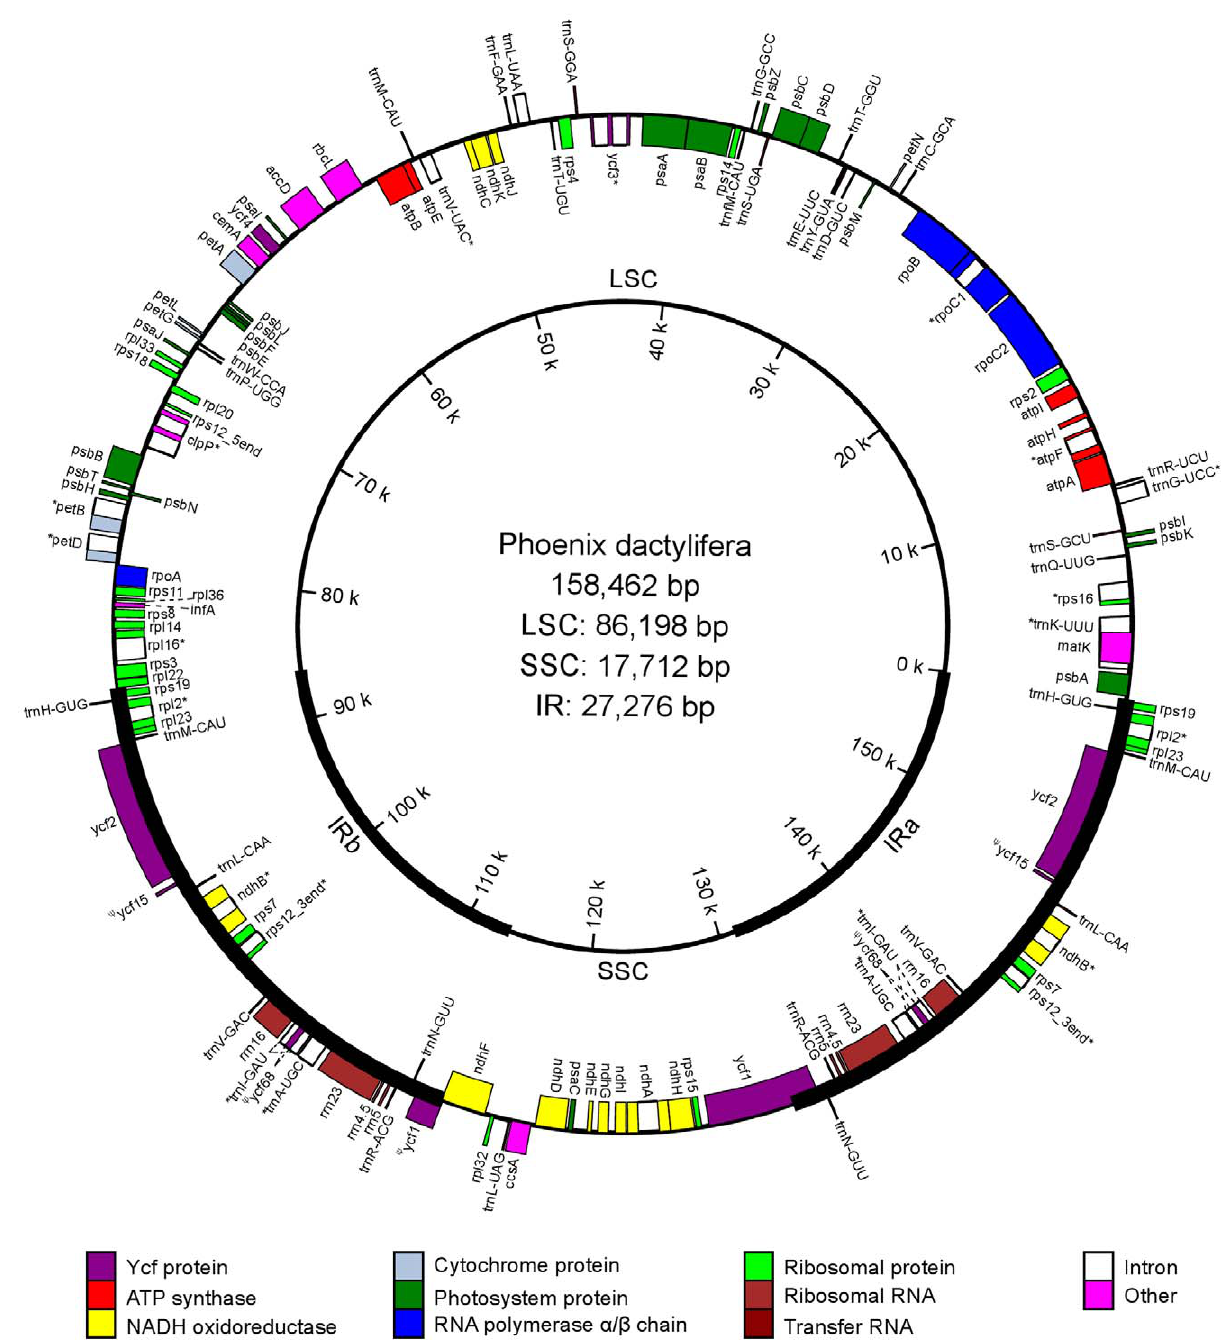
Figure 1. The map of date palm cp genome sequence. Genes shown outside the outer circle are transcribed clockwise, whereas those shown inside are transcribed counterclockwise. The thick line indicates IRs. The genome coordinate is shown in the inner circle. Genes belonging to different groups are color-coded ( Y , pseudogene).